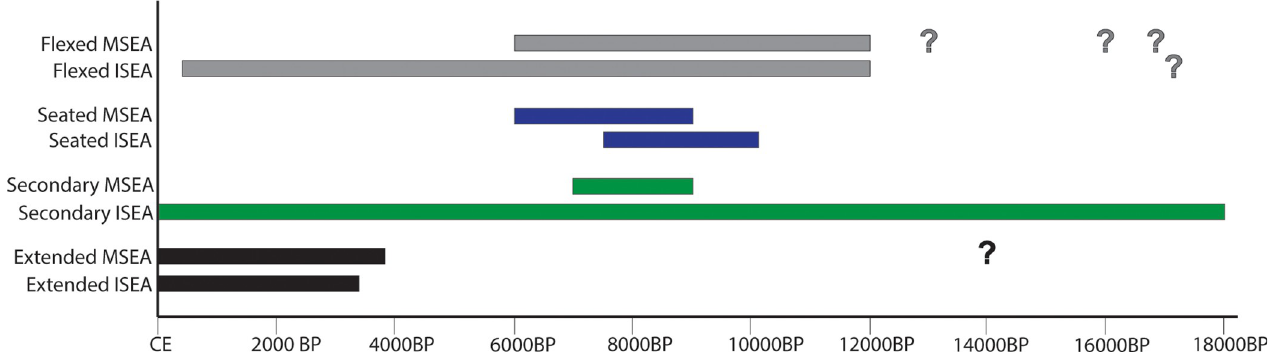
Fig 12. Chronology of burial types. Bar chart showing the chronology of the different burial types discussed in this paper. Question marks indicate possible burials, which chronology or burial type is uncertain (see discussion text).